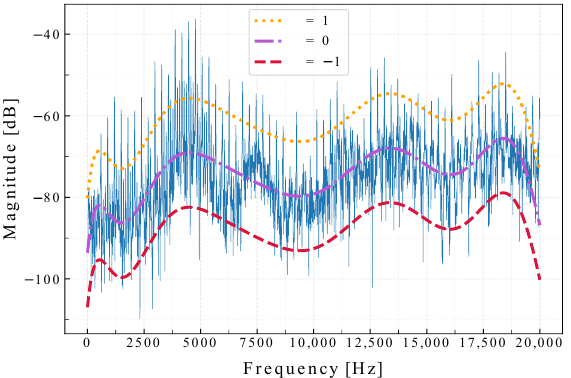
Figure 3. Twelfth order polynomial threshold curves of PlasmaDerm ® Flex sound frequency spectrum with different η values on top of the PlasmaDerm ® Flex sound frequency spectrum.